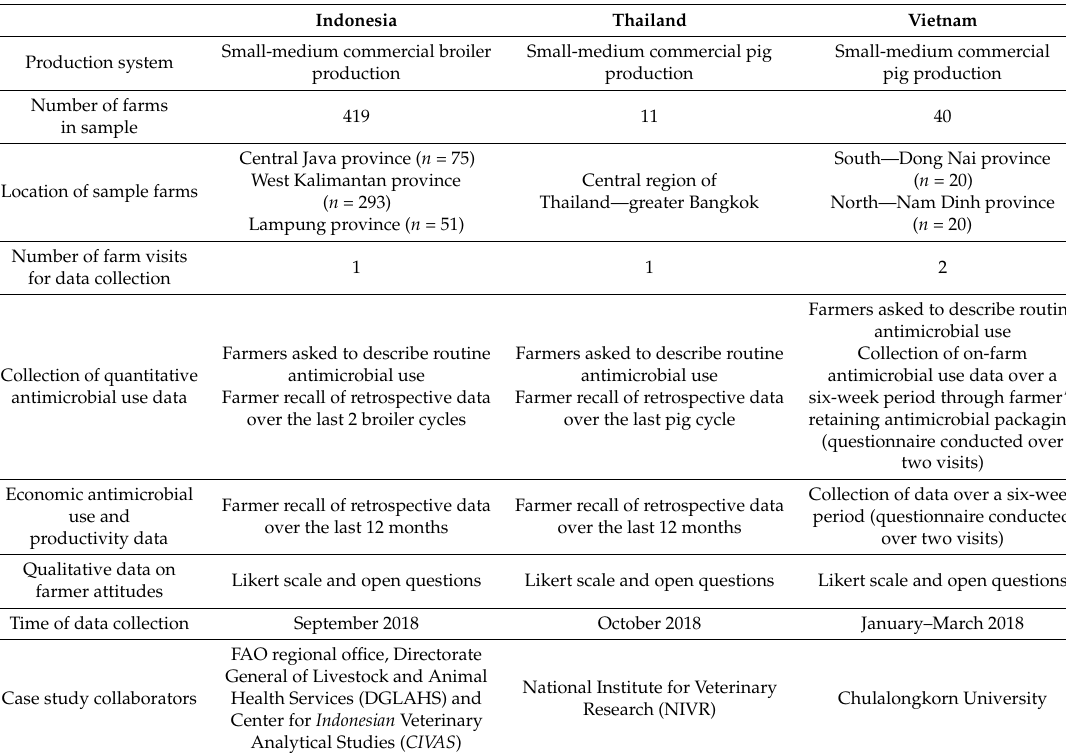
Table 9. An overview of the materials and methods used to characterize the economics of antimicrobials and describe antimicrobial use behaviors and attitudes to AMR in key livestock sectors in Indonesia, Thailand, and